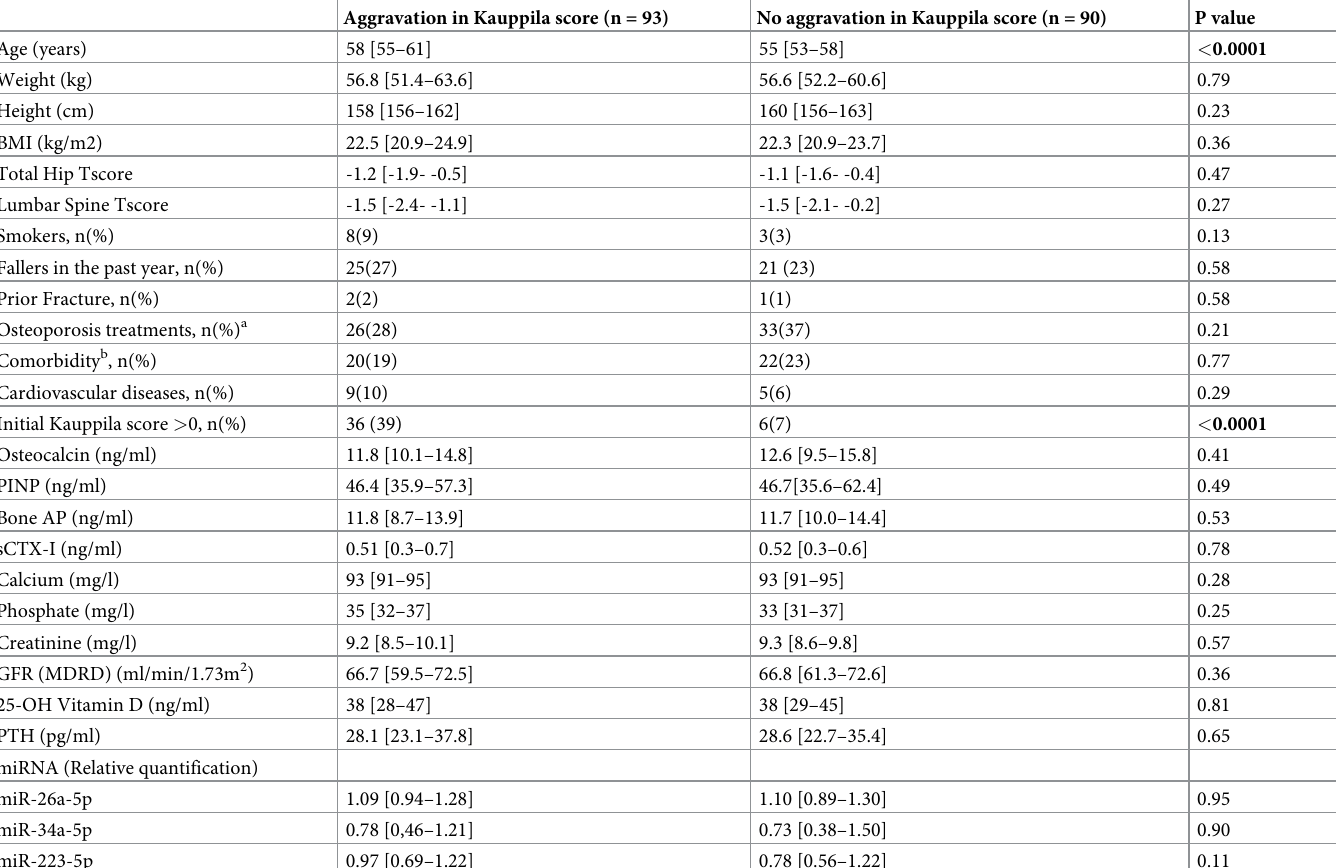
Table 4. Baseline demographic and biological characteristics of 183 women with versus without an aggravation in Kauppila score during 17 years of follow-up (median [interval interquartile]) and miRNA quantification (median [interval